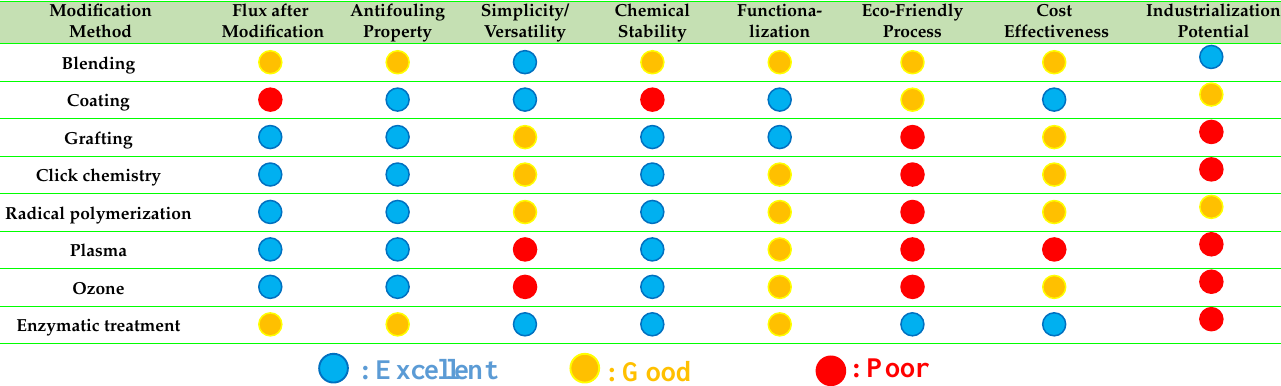
Table 4. Qualitative comparison of different membrane modification methods.